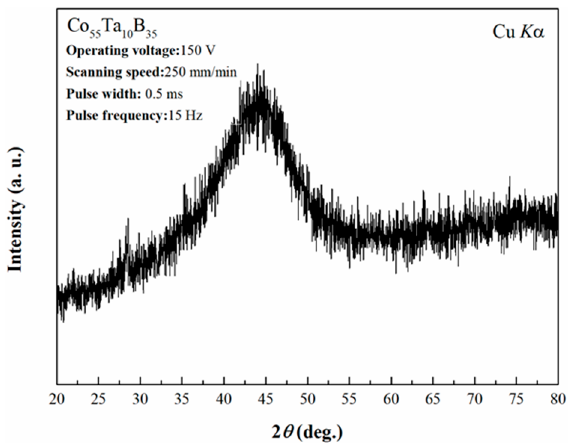
Figure 2. XRD pattern of Co 55 Ta 10 B 35 amorphous coating prepared by laser cladding.